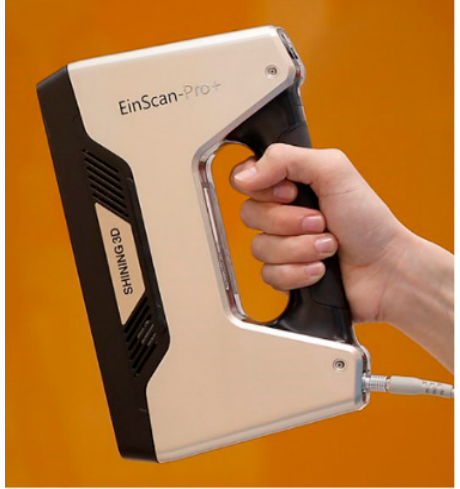
Figure 11. 3D Scanner used for this study.